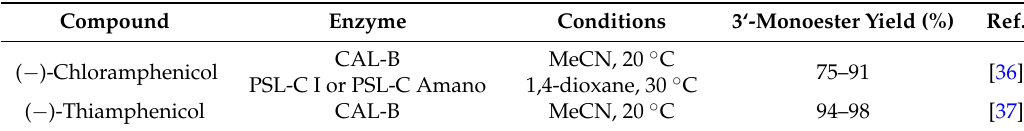
Table 2. Optimized conditions for the regioselective enzymatic acylation of ( − )-Chloramphenicol and ( − )-Thiamphenicol.